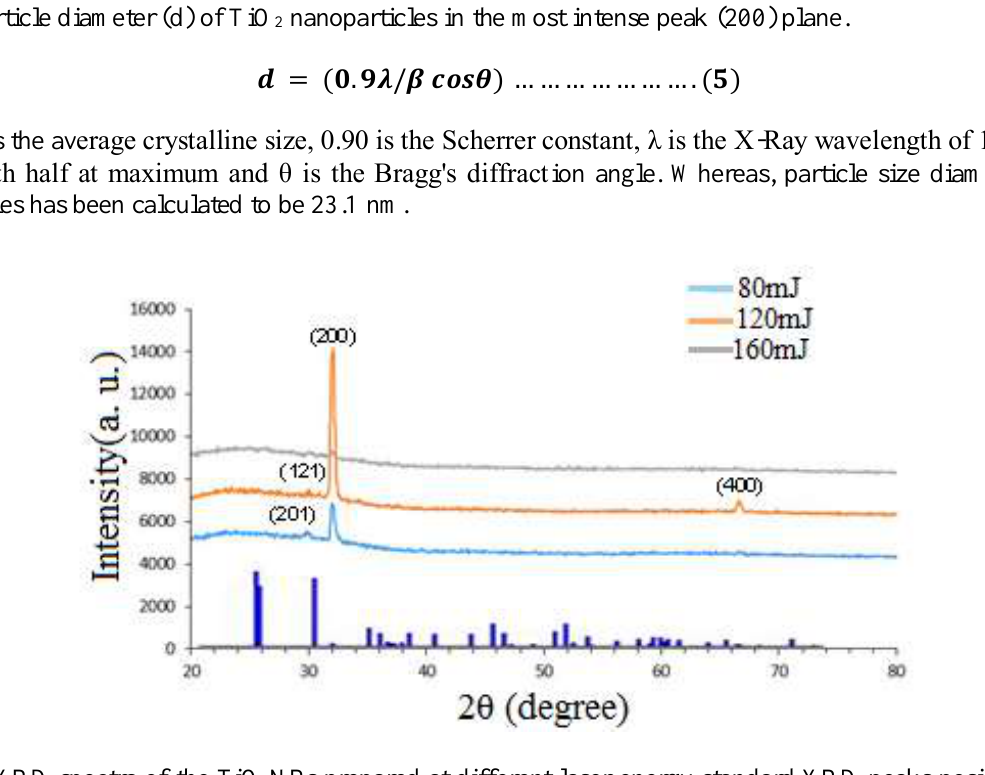
Figure 5: XRD spectra of the TiO 2 NPs prepared at different laser energy standard XRD peaks positions pattern of Brookite TiO 2 placed on